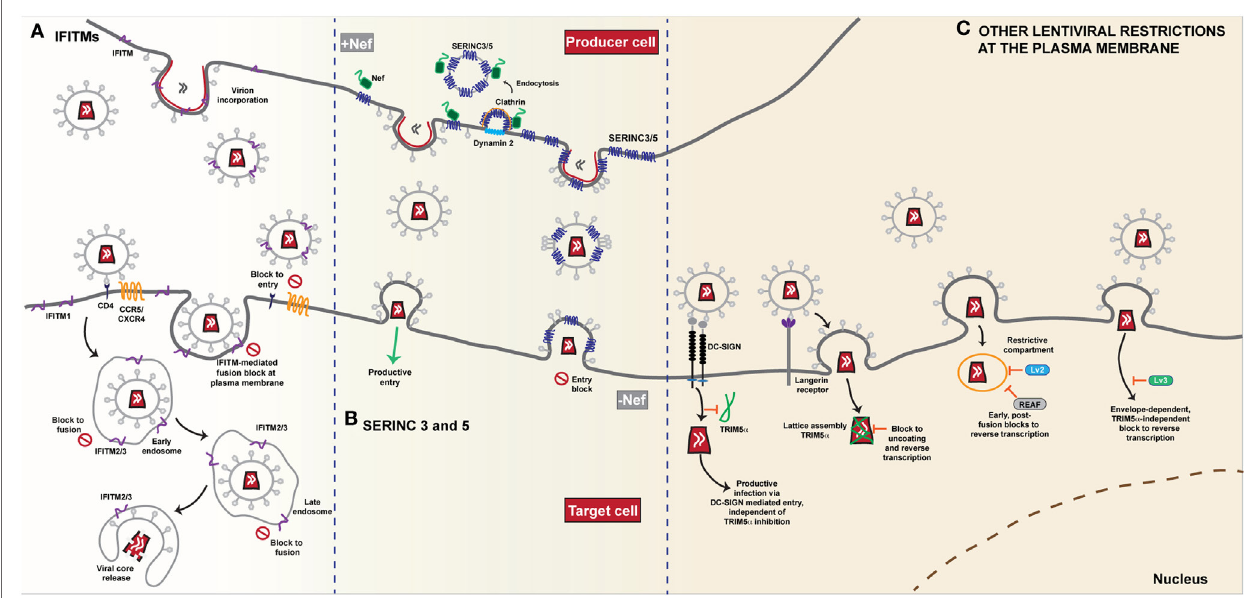
FigURe 2 | Restriction of HIV-1 entry at the plasma membrane. (A) IFITMs. The antiviral restriction activity of the interferon induced transmembrane (IFITM) protein family appears to be linked to the site of viral fusion. The current general mechanism of action proposed, i.e. the physical fusion of the viral and host cell membranes is blocked, accounts for the diversity of viruses that IFITMs restrict. The influence of complex cellular trafficking pathways on this mechanism is yet to be determined. IFITMs 1, 2 and 3 are localised in different membrane compartments; IFITM1 primarily at the plasma membrane and IFITMs 2 and 3 in overlapping intracellular endocytic compartments-the sites of enveloped virus fusion. HIV-1 entry requires the CD4 receptor and co-receptors CCR5 or CXCR4 and it appears that HIV-1 sensitivity to IFITM restriction is influenced both by IFITM localisation and the site of fusion. Fusion that occurs at the plasma membrane is susceptible particularly